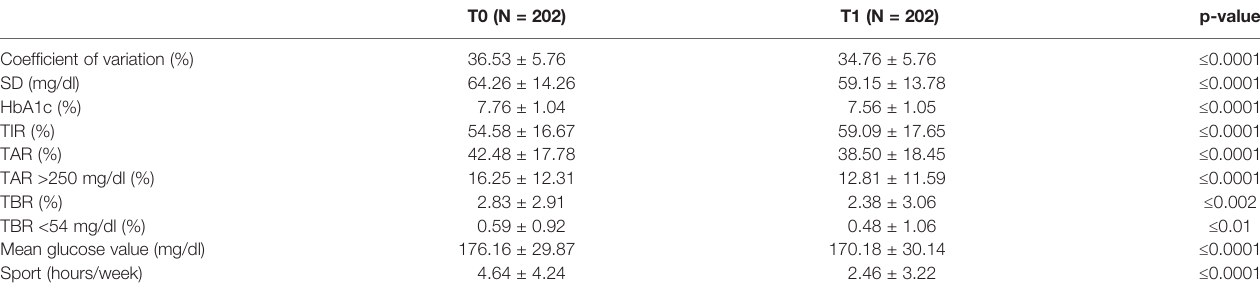
TABLE 2 | Primary outcome: Glycemic control at T0 and